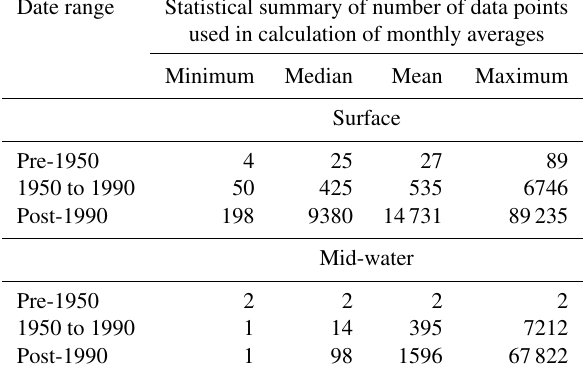
Table 4. Rounded statistical summary of data used to calculate monthly averages. Date range Statistical summary of number of data